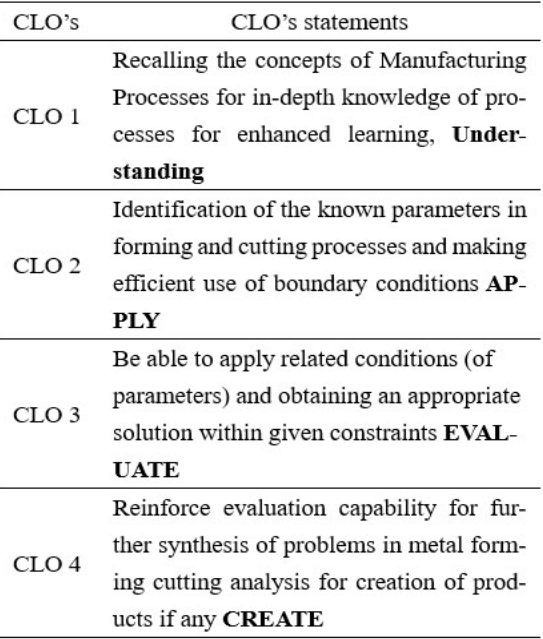
Table 3. Course learning outcomes for Metal forming and cutting analysis